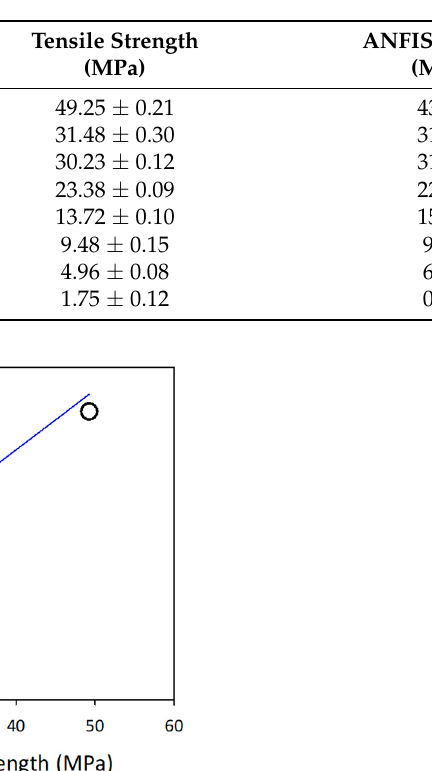
Table 4. Comparison experiment data with forecast data ANFIS.